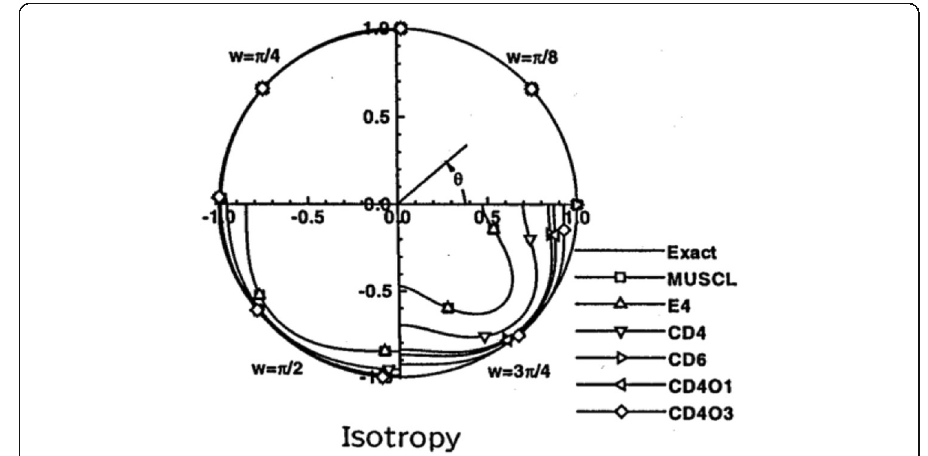
Fig. 4 Comparison of isotropic error of compact-difference scheme with others